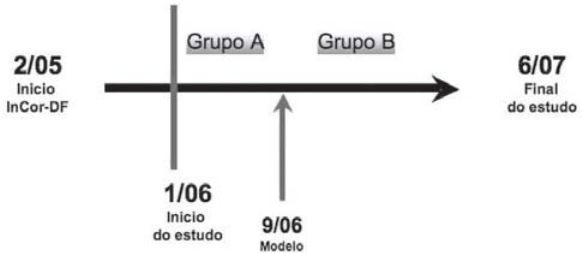
Fig. 2 - Linha temporal do trabalho, incluindo a definição dos grupos